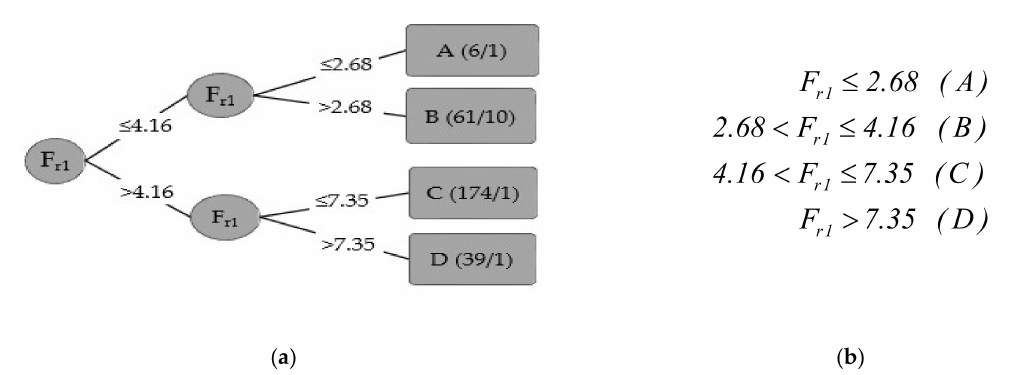
Figure 2. Decision tree and classification chart of the hydraulic jump in a natural rough bed: ( a ) Decision tree classifier model (the numbers in brackets (e.g., 6 / 1 for class A) stands for the total number of data (e.g., 6) and the false classifications (e.g., 1) falling in each class, respectively). ( b ) Classification chart.